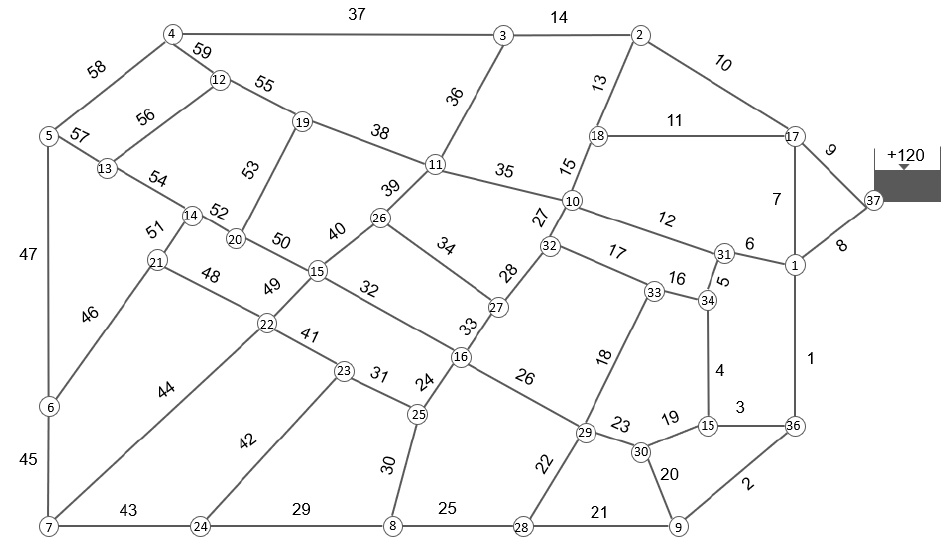
Figure 6. Network schematic of Fossolo distribution system.